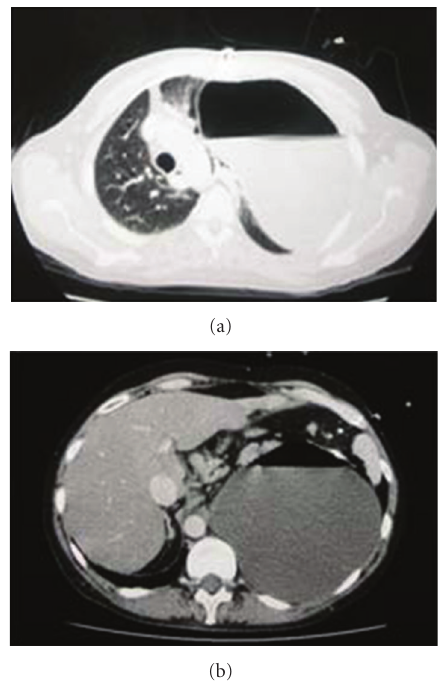
Figure 14: Axial CT scans on the same patient as in Figures 13 and 14 showing diaphragmatic rupture and herniation of the stomach into the left